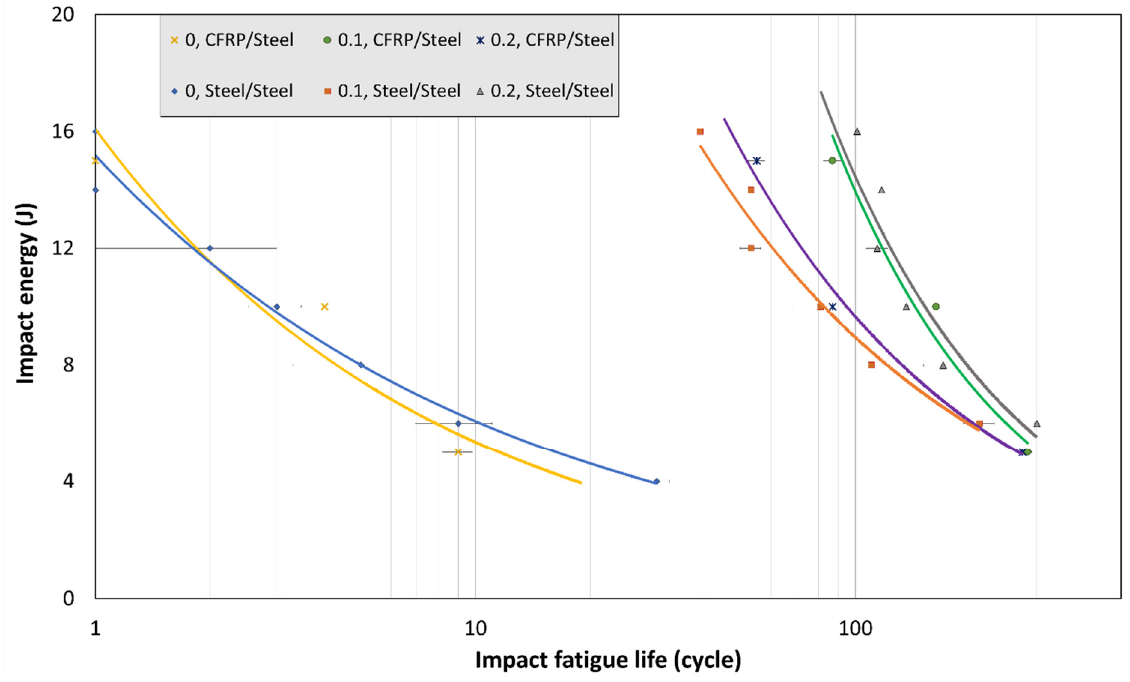
Figure 7. J-N response of similar and dissimilar bi-adhesive single lap joints subjected to cyclic im- pact